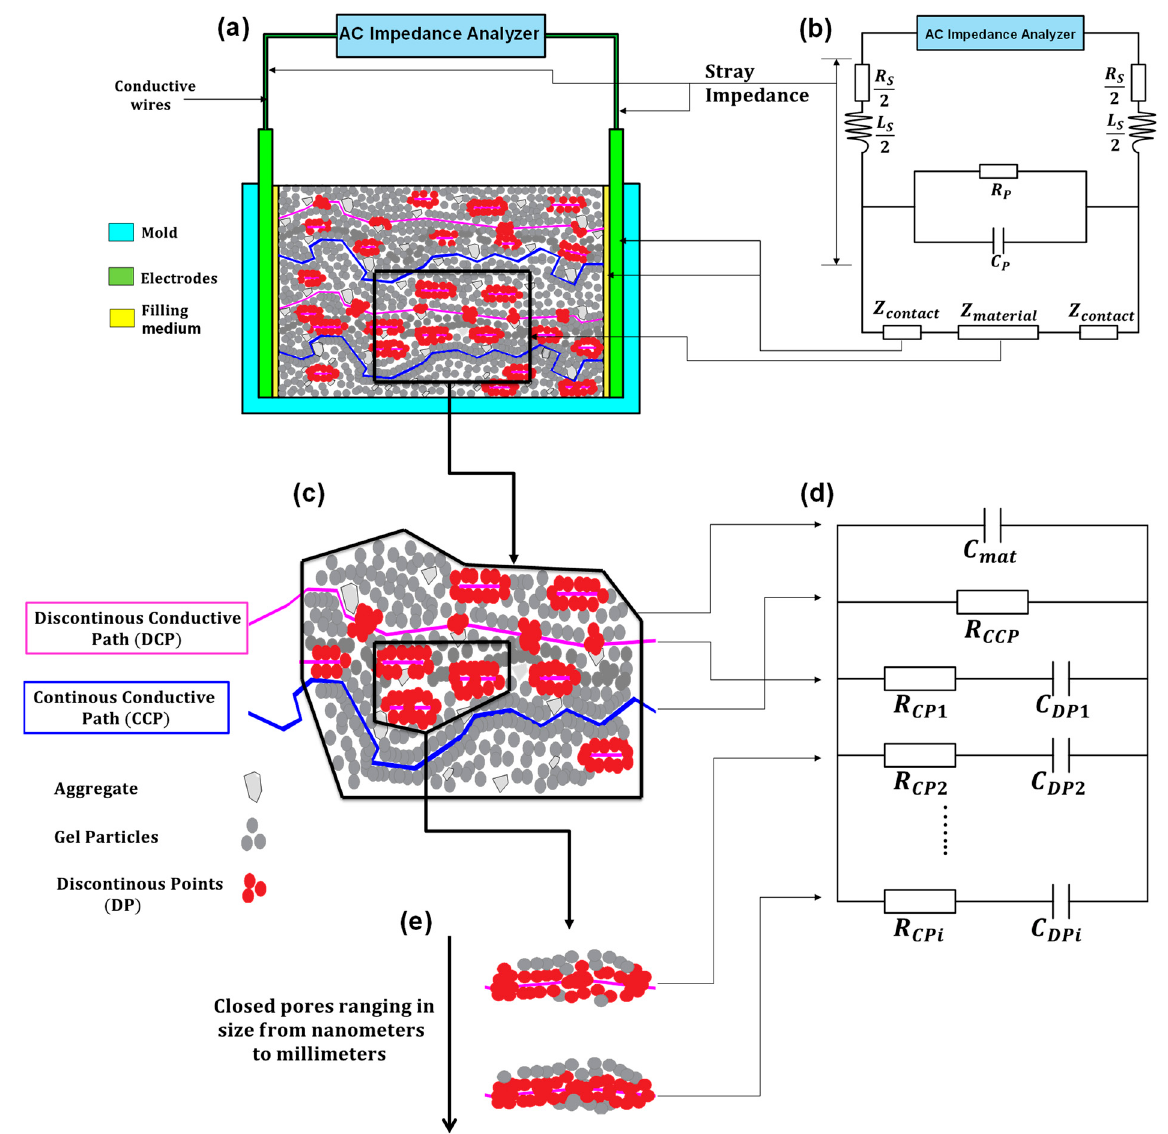
Figure 13. The cement-based microstructural analysis using ACIS.